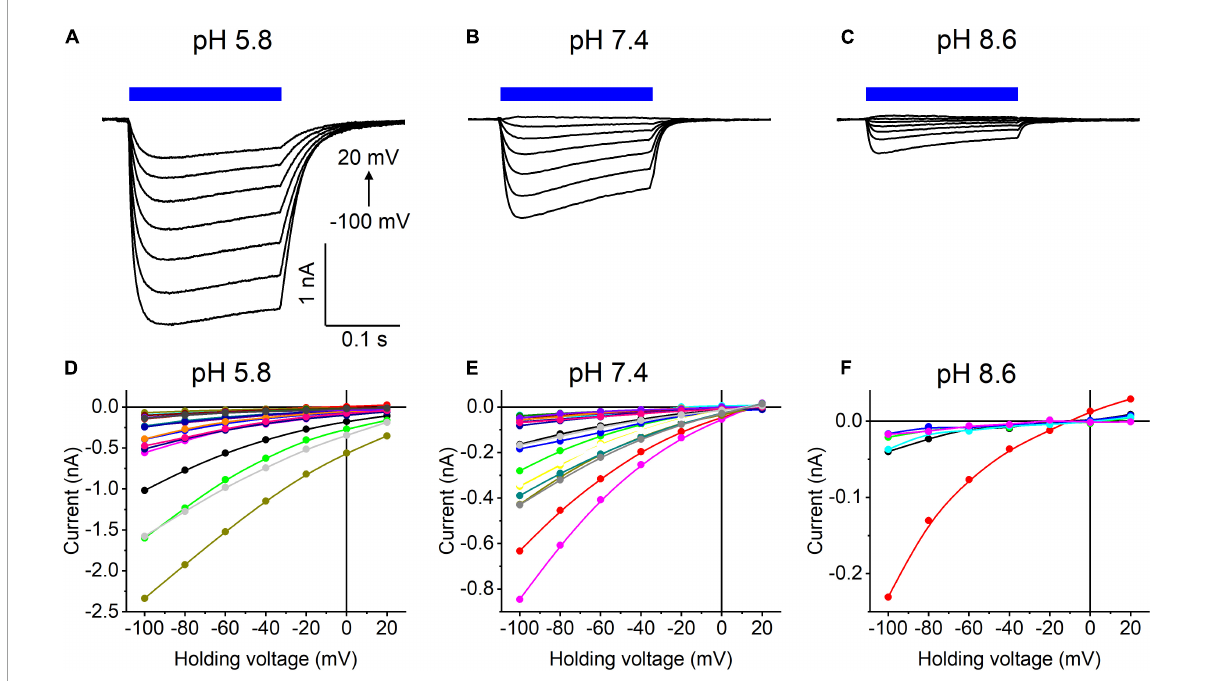
FIGURE3 (A–C) Photocurrent traces recorded from Cr ChR2 at the indicated external pH in response to a 200-ms light pulse (470 nm, 475 mA), the duration of which is shown as a colored bar on top. The holding voltage was varied from –100 to 20 mV in 20-mV steps. (D–F) Current-voltage relationships of Cr ChR2 measured in individual cells. The current amplitude was measured at the end of a 200-ms light pulse.